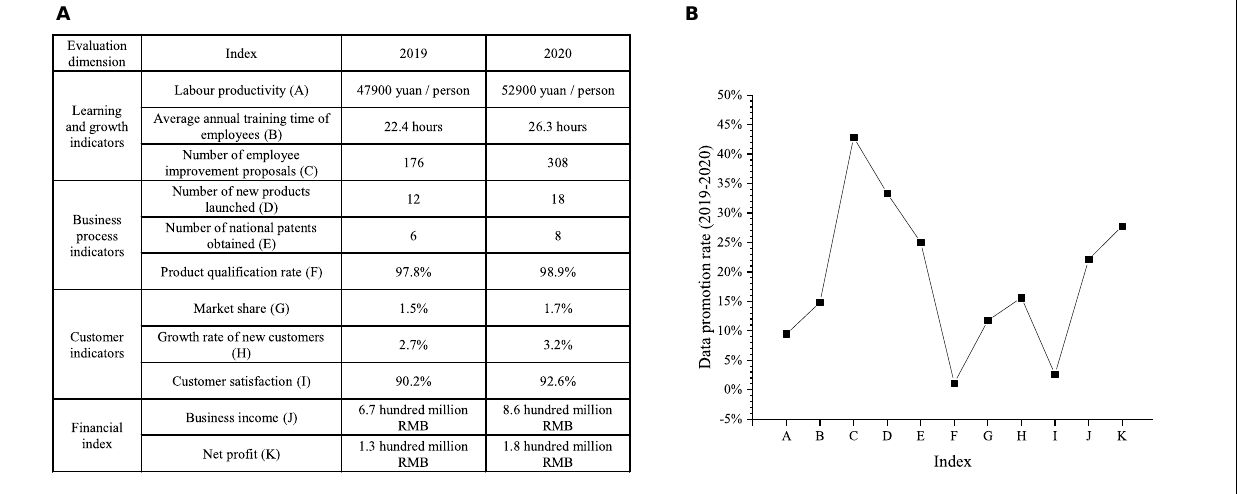
FIGURE 13 | Comparison of index data for 2020 and 2017 (A) specific data (B) data enhancement